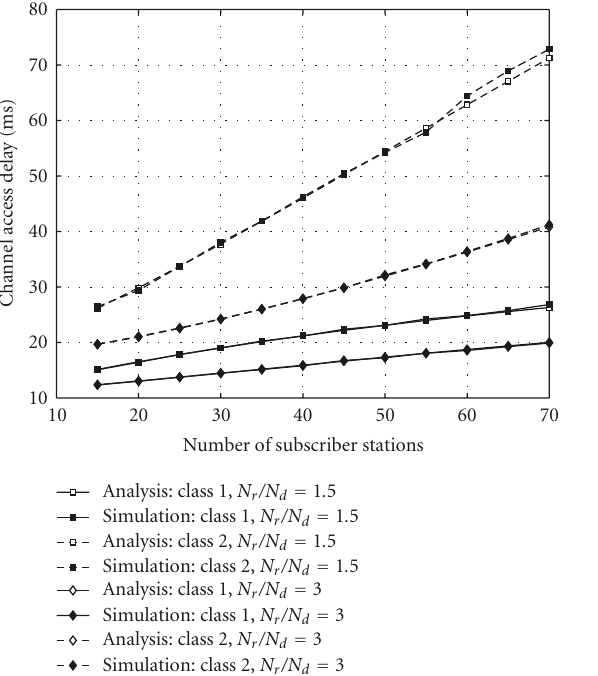
Figure 9: REQ transmission probability of SS versus the number of SSs with equal bandwidth allocation priority, and di ff erentiated channel access parameters: W 0,1 = N r , W 0,2 = 3 N r , W x ,1 = 2 4 W 0,1 and W x ,2 = 2 8 W 0,2